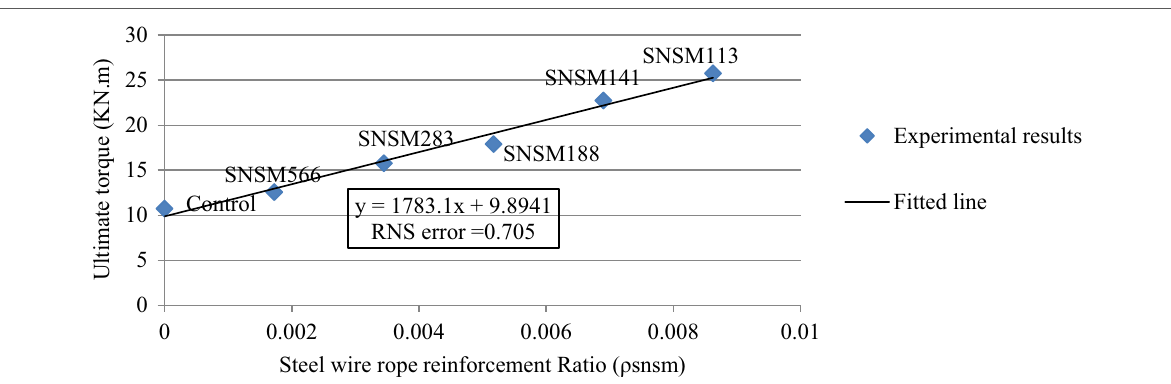
Fig. 10 Influence of NSM steel reinforcement ratio on the torsional strength of concrete